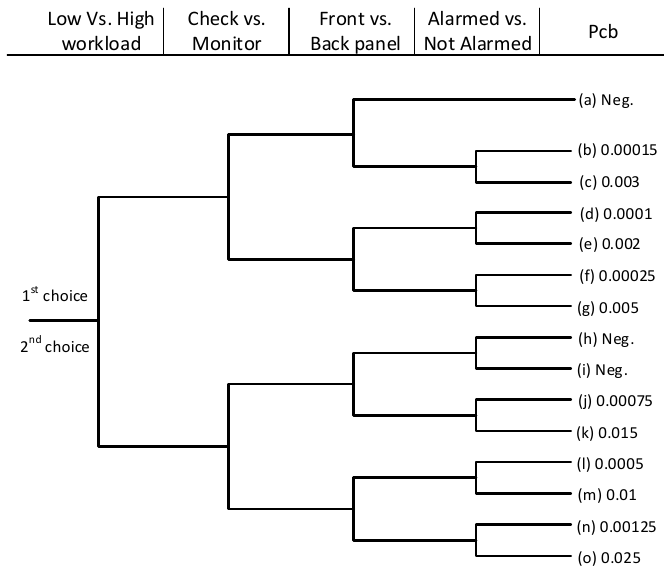
Figure 8. Pcb in the MCBDT. Table 4. Pcb evaluation HEPs in MCBDT and their sources.